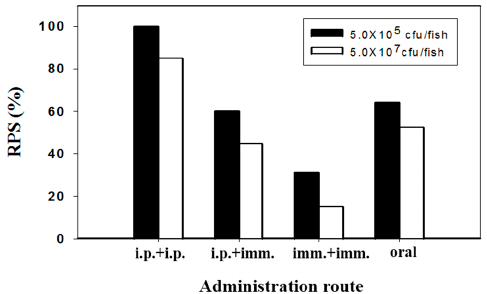
Figure 2. Protection (RPS) of silver sea bream ( N = 30–33) against virulent V. alginolyticus challenge after three weeks of vaccination with formalin-killed bacterins through different administration routes. (RPS = (1 − mortality of vaccinated fi sh/mortality of control fish) × 100).